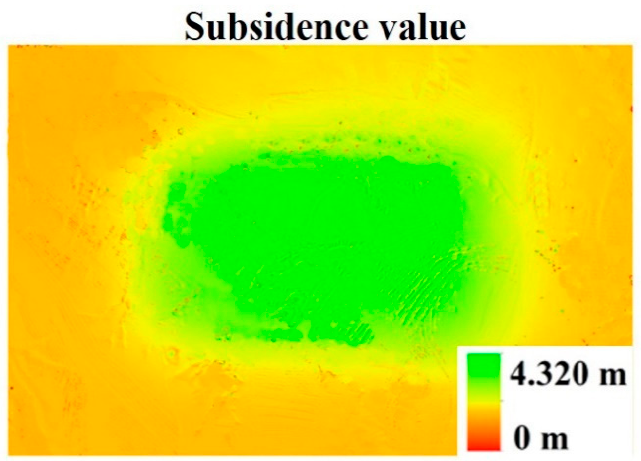
Figure 3. Ground subsidence of the study area. The figure was obtained by subtracting the DEM of 1 September from the DEM of 30 May. Source: Built on the DEM obtained from UAV images.